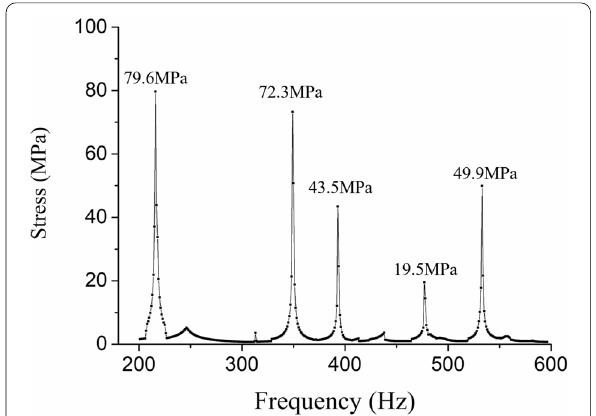
Figure 4 Stress frequency response curve of multi-support pipeline